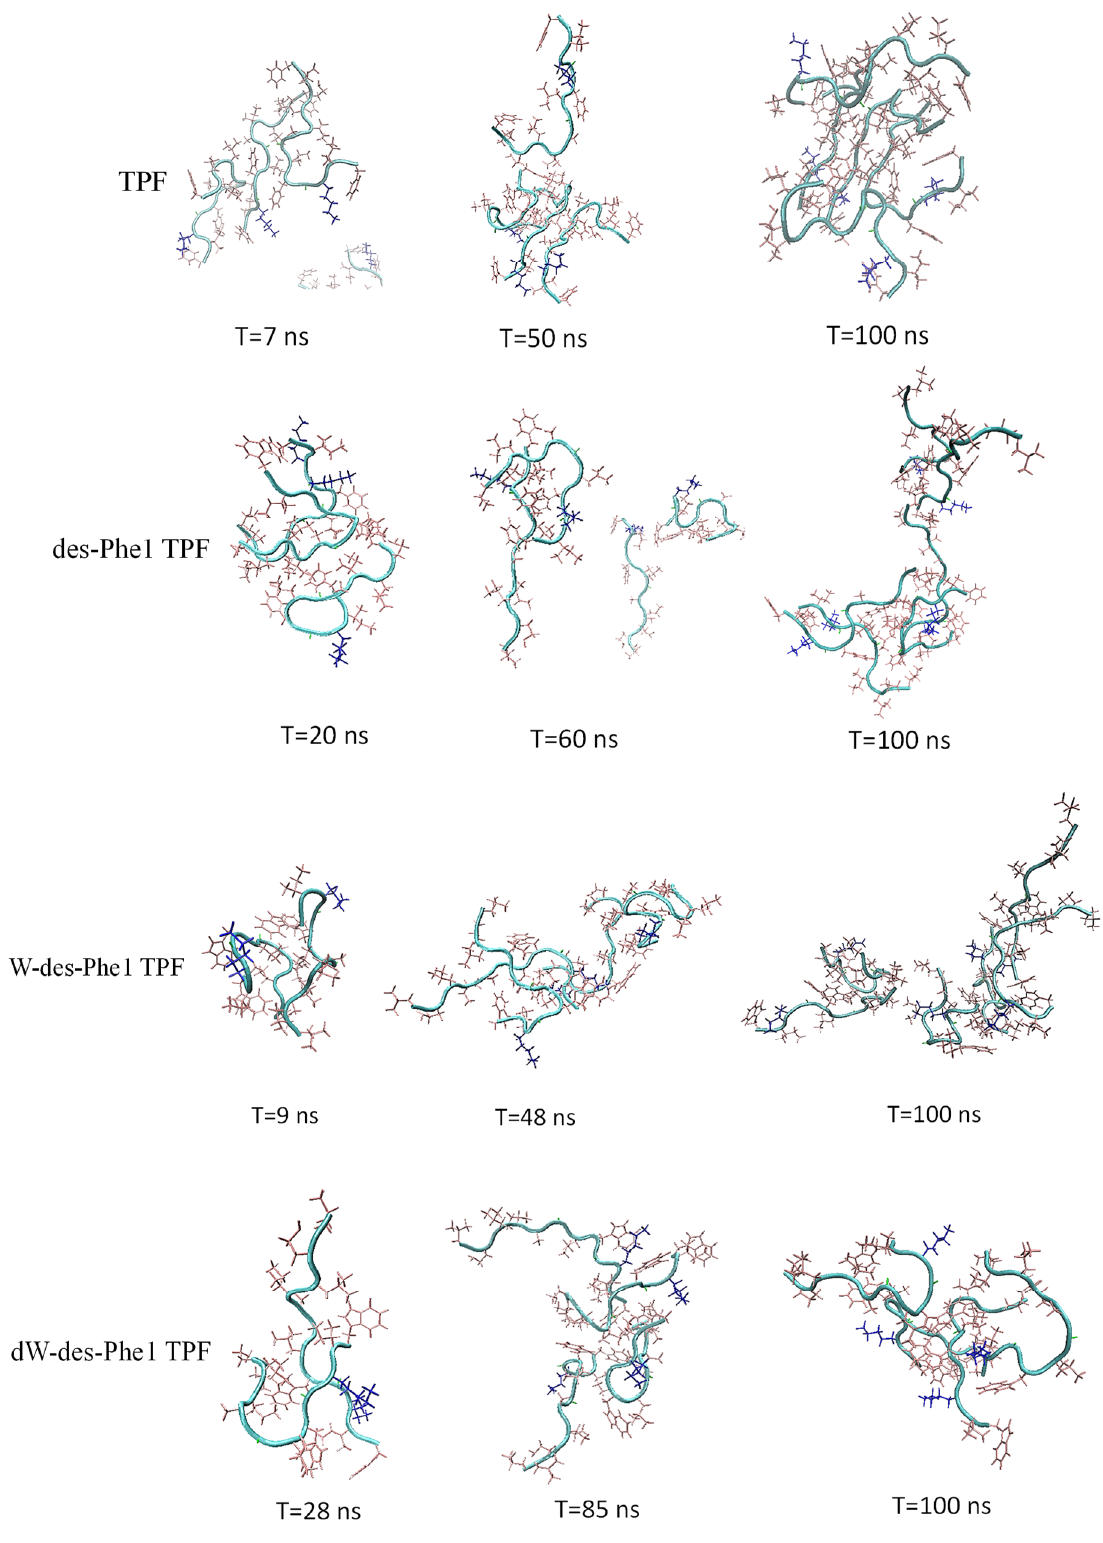
Figure 6. The snapshots of the trajectory of the aggregation simulation of the peptides. The frames at different time points were represented based on the oligomerization state analysis in Figure 5. The positively charged residues and nonpolar residues were represented by blue and pink, respectively.